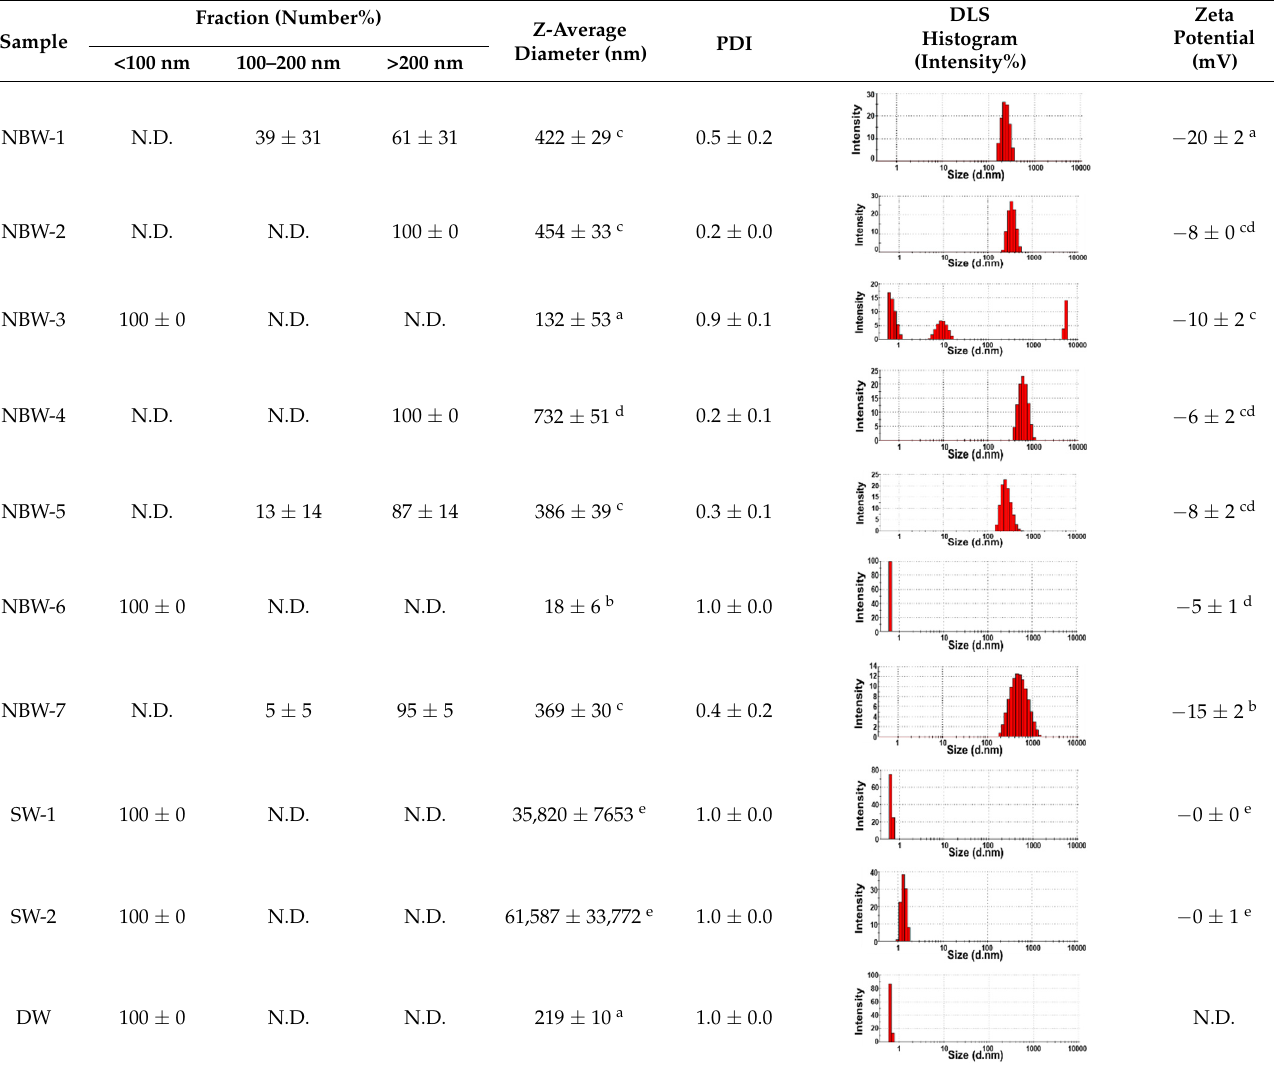
Table 2. Particle fractions, hydrodynamic diameters, and surface charges of bubbles in NBWs or in conventional SWs 1 . Sample